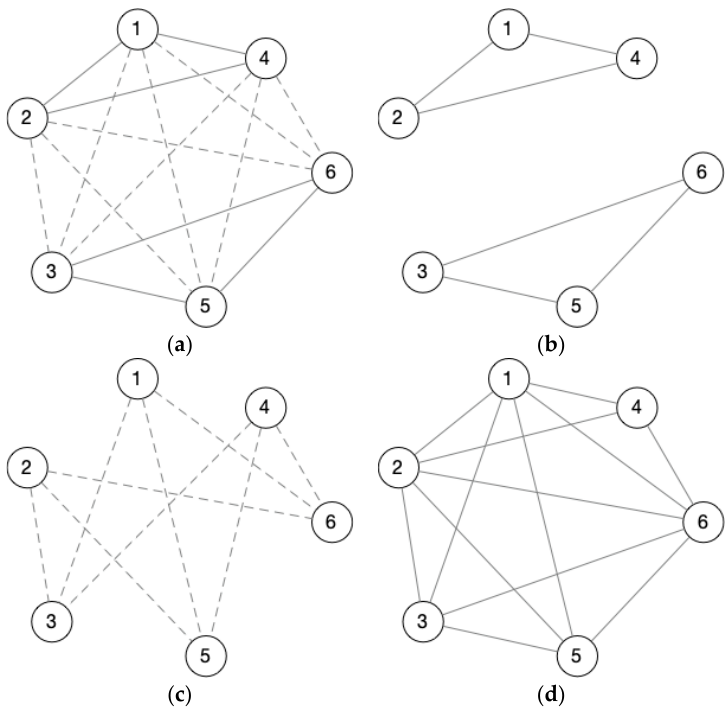
Figure 6. A signed network graph and subgraphs of different weighted edges, ( a ) is the original signed network graph, ( b ) is the subgraph of ( a ) with all positive edges, ( c ) is the subgraph of ( a ) with all negative edges, and ( d ) is the unweighted edges graph.